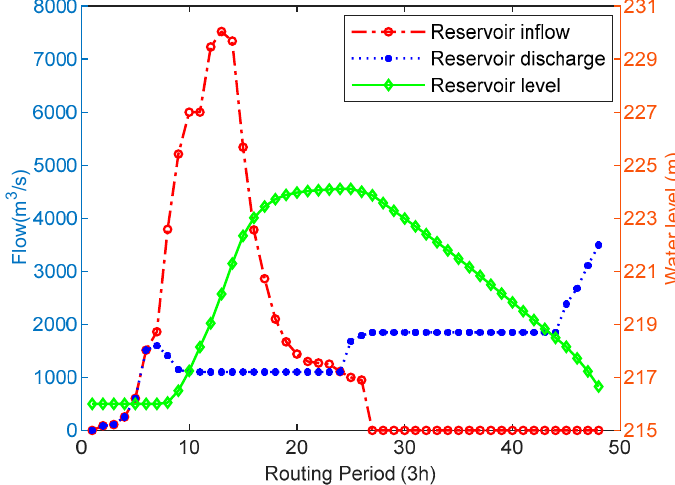
Figure 7. Operation process using ε -BES for reservoirs in Luanhe River Basin .